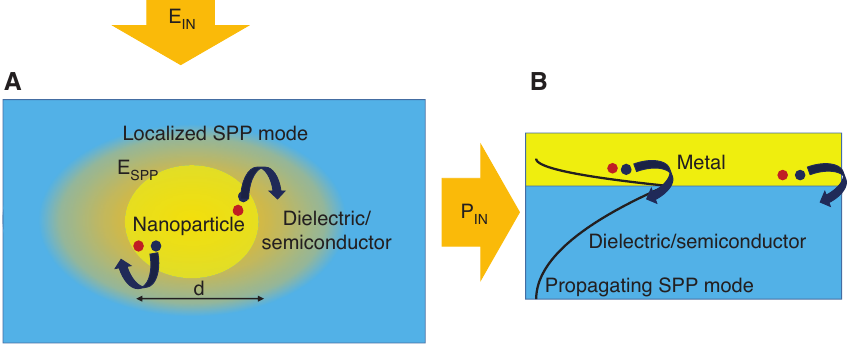
Figure 1: Plasmon-assited hot carrier generation and injection. Geometry of hot electron-hole pair generation in the metal with subsequent injection into the semiconductor/dielectric using (A) localized SPPs (mostly used in photocatalysis) and (B) propagating SPPs (mostly used in photodetection). As explained in the text, at realistic optical powers, SPPs never coexist with hot carriers at the same